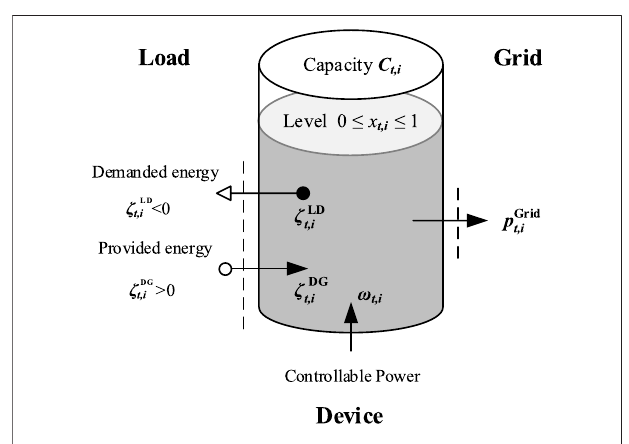
FIGURE 2 | Uni fi ed model of power exchange at